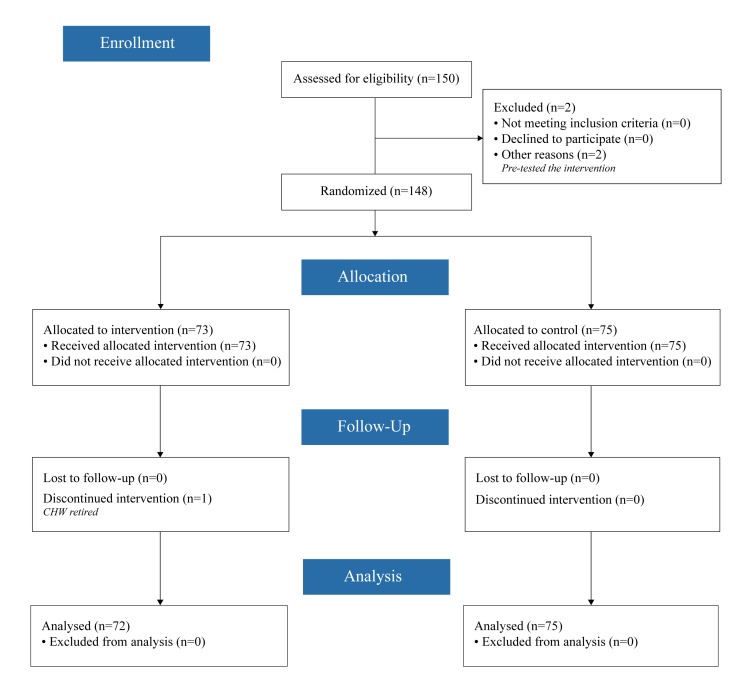
CONSORT diagram.